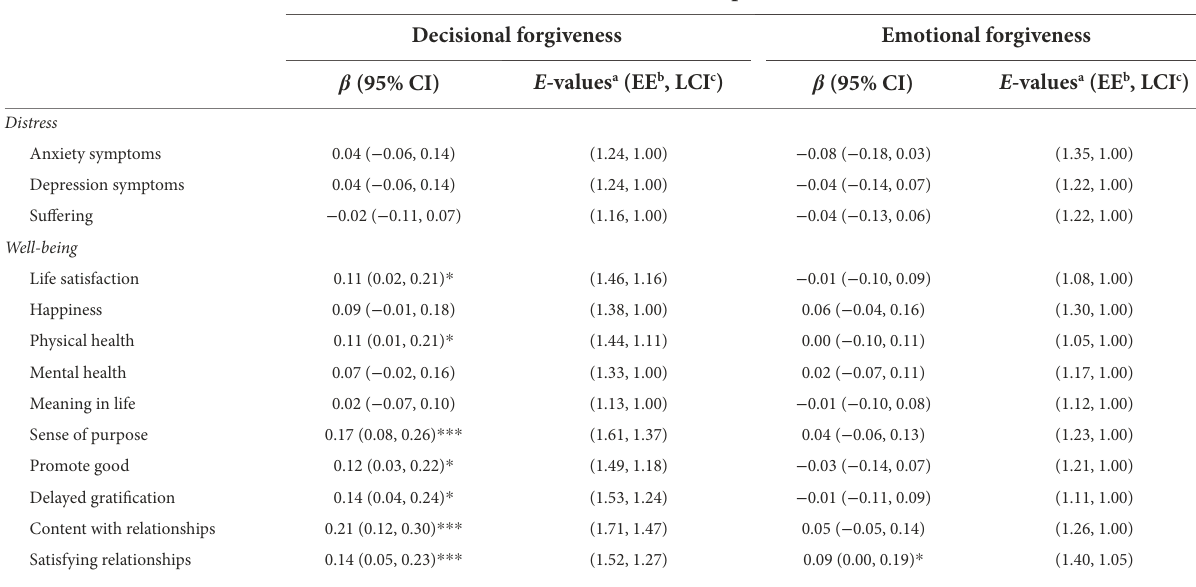
TABLE 1 Associations of decisional and emotional forgiveness (T 2 ) with distress and well-being outcomes assessed 1 month later (T 3 ). Outcome Exposure Decisional